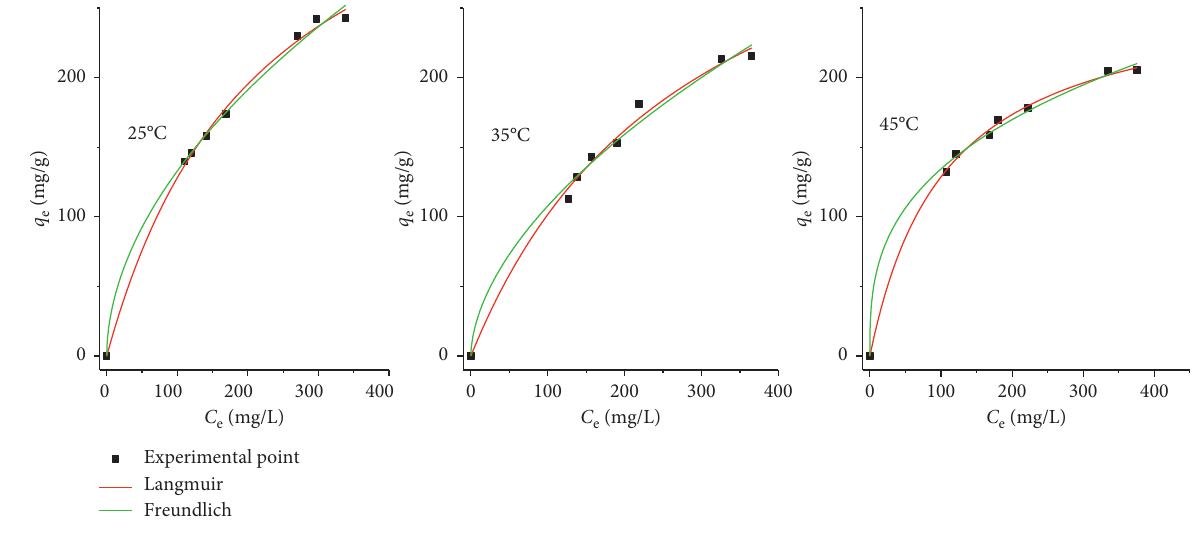
Figure 11: Adsorption isotherm for polyphenols onto ghassoul clay.